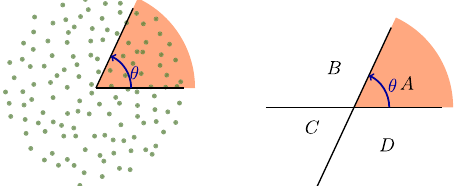
Fig. 1 Corner geometry. Left: Subregion A is highlighted in red. The electron distribution is a typical Monte Carlo sample obtained from the topological fractional quantum Hall ground state at fi lling ν = 1/3. Right: The regions that are used in the substraction procedure for canceling out the boundary law, and isolating the corner